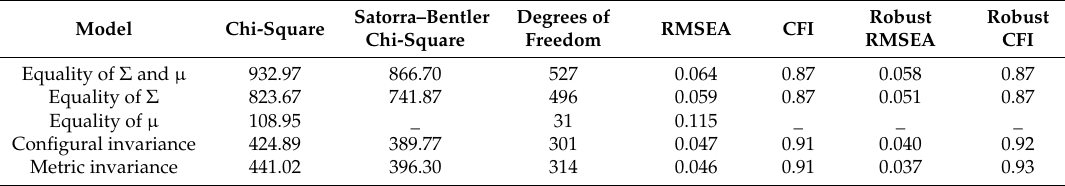
Table 1. Model comparisons across